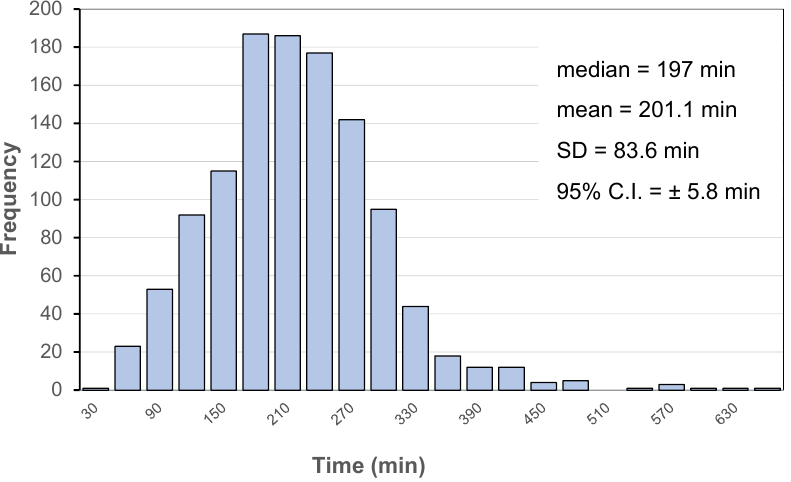
Figure 9. SITT distribution in 1179 volunteers. Data collected regardless of dosage form type and food intake, organized into 22 classes each of 30 min.